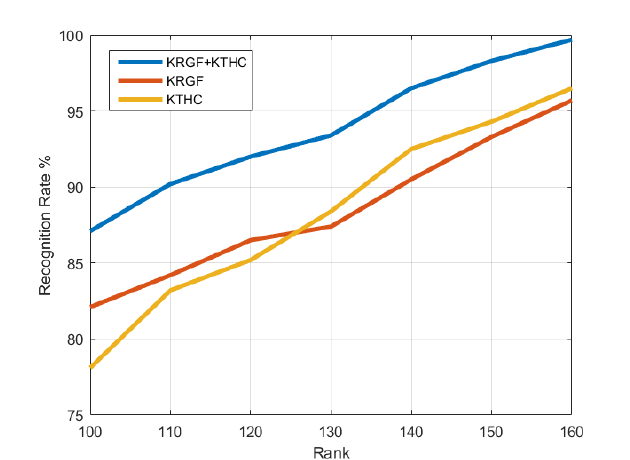
Figure 8. The recognition rate for three proposed features with different feature dimensions: the kernelized Riemannian geometric feature (KRGF), the kernelized Riemannian temporal hierarchy of covariance (KRTHC) feature, and their fusion (KRGF + KRTHC) on the walking sequence in our